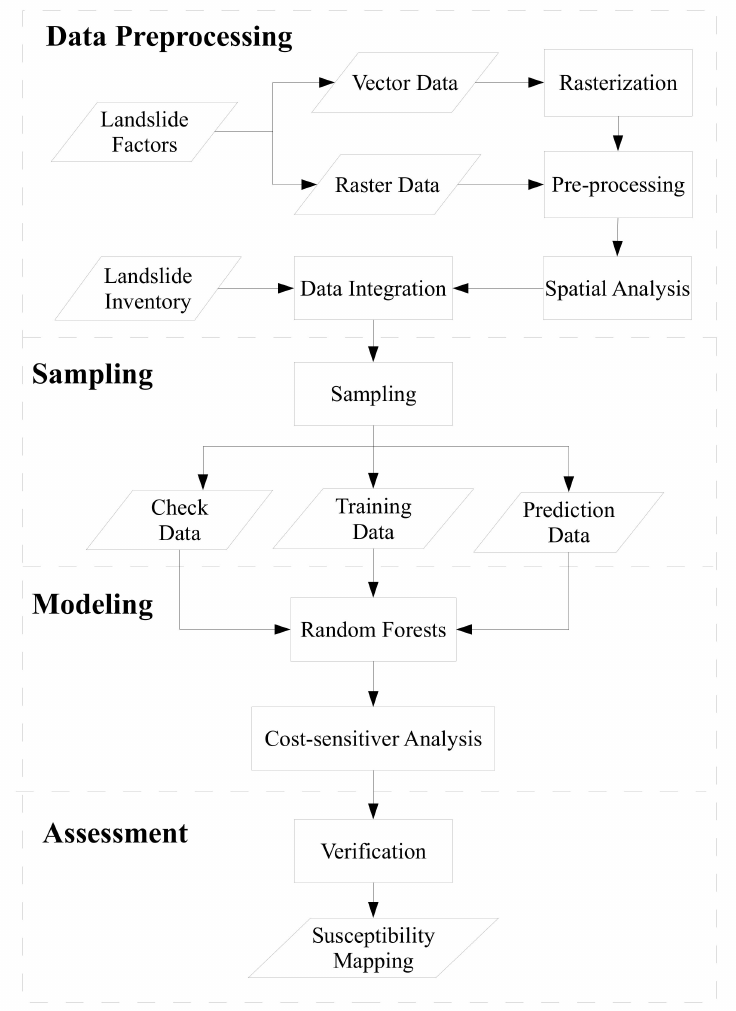
Figure 2. Procedure for the developed machine learning based landslide susceptibility